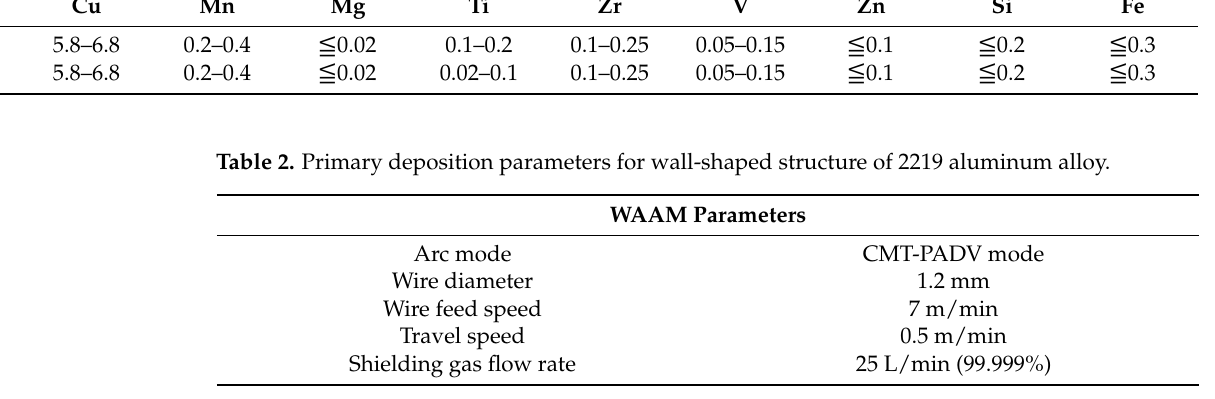
Table 1. Chemical composition of ER2319 wire and 2219-T87 plate. Alloys Chemical Composition (wt.%)